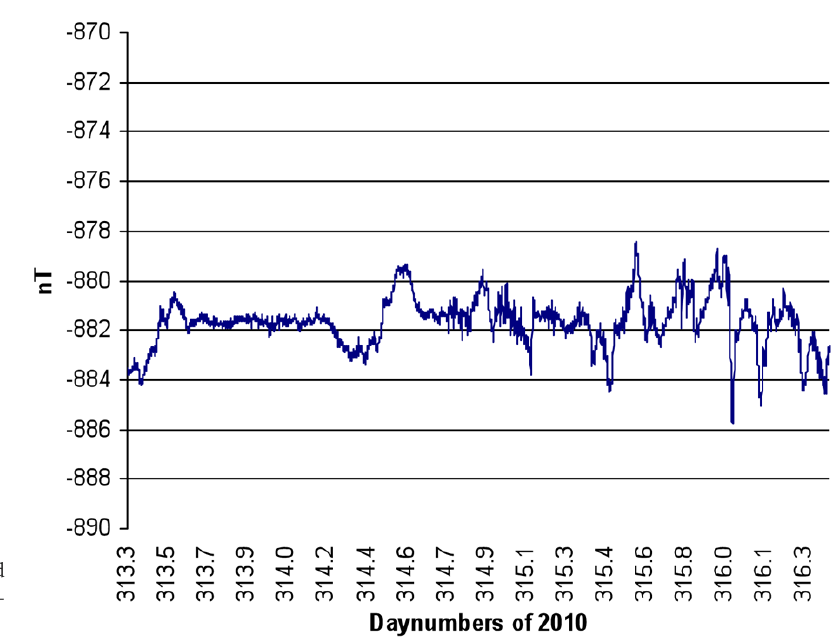
Figure 14. The difference of X component magnetic field between the Aggtelek repeat station and Tihany obser- vatory (minute mean